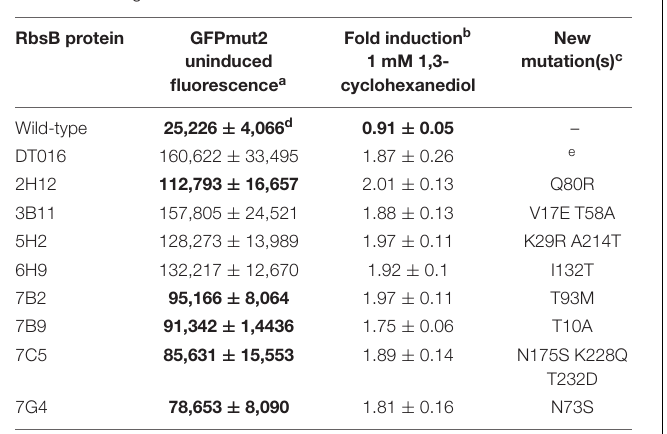
Frontiers in Bioengineering and Biotechnology |